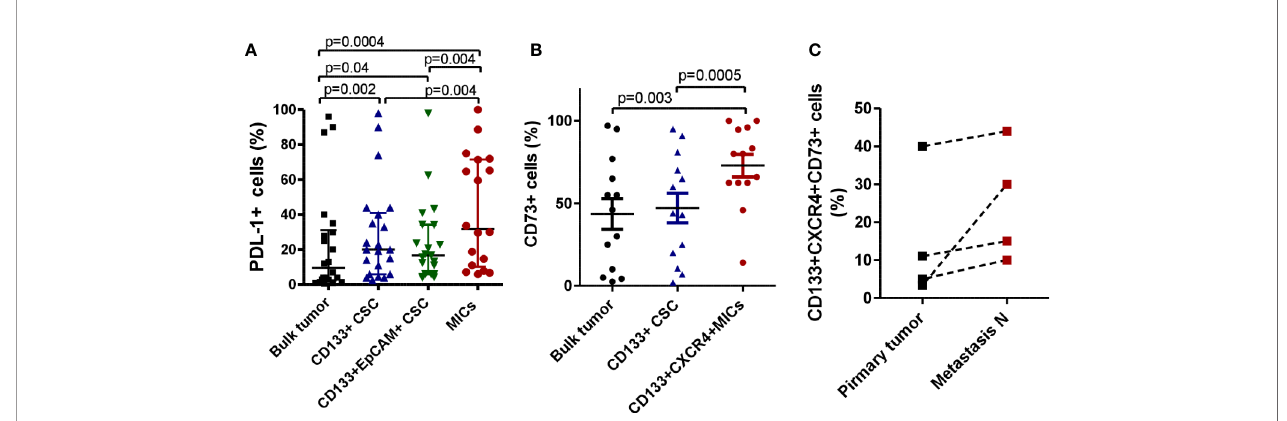
FIGURE 1 | MICs highly expressed immunoregulatory markers. (A) FACS analysis of N=22 NSCLC primary tumors. PD-L1 expression was assessed within bulk tumor population and different subsets of CD133+ Cancer Stem Cells, the epithelial one (EpCAM+) and the mesenchymal and metastatic one (CD133+CXCR4+ EpCAM- Metastasis initiating cells MICs). (B) FACS analysis of N=13 NSCLC primary tumors for the expression of CD73 within bulk tumor and different CSC subsets. (C) Comparison of CD73 expression by FACS analysis in n=4 primary tumors and synchronous lymph node